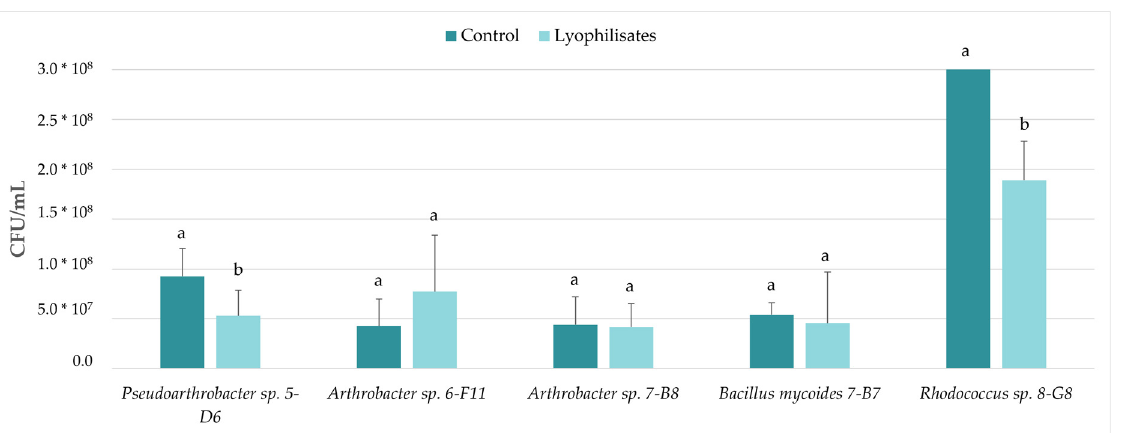
Figure 3. Effect of lyophilization on the viability of isolates. The bars indicate the mean of the three biological replicates and the thin lines their standard deviation values. The letters above each of the bars indicate statistically different groups generated in the Student’s t test.